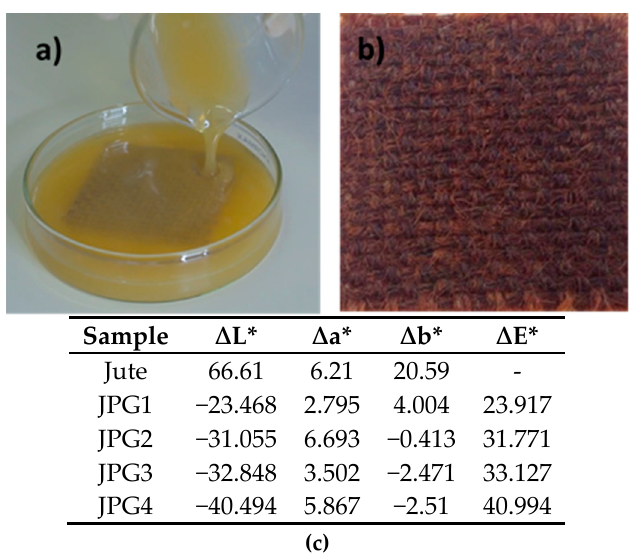
Figure 3. ( a ) Jute fabric impregnated with Ag 0 -PEG suspensions; ( b ) jute fabric with Ag 0 -PEG NPs; ( c ) CIElab color coordinates. Table 2. Samples of jute with Ag NPs synthesized with PEG and the respective resistivity and conductivity values.